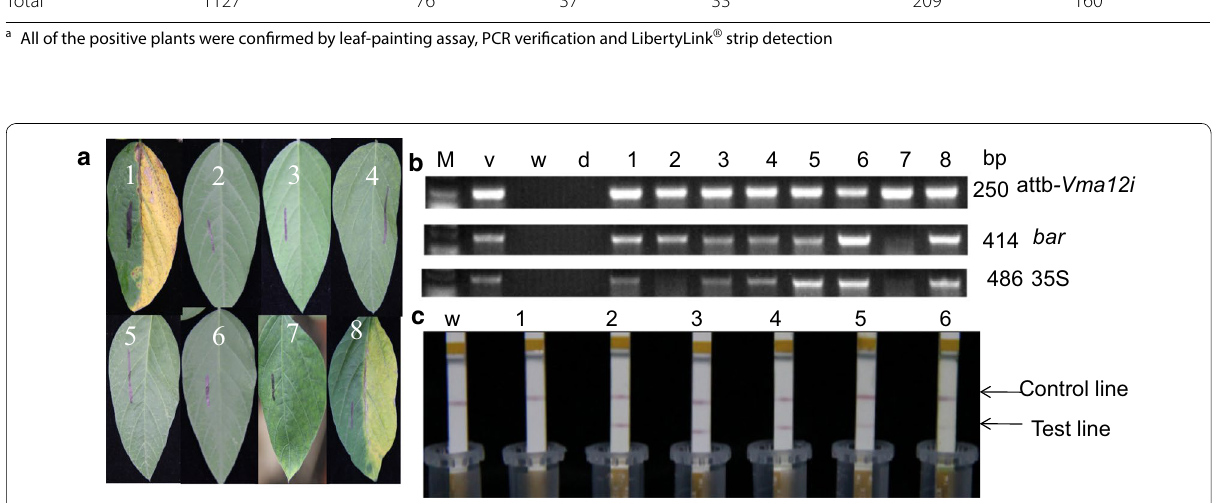
Fig. 2 Identification of T 0 transgenic soybean plants. a Identification of T 0 transgenic soybean plants by herbicide painting, 1: wild type Tianlong No.1; 2–7: herbicide resistant plants; 8: herbicide nonresistant plant. b Identification of T 0 transgenic soybean plants by PCR, M: Marker D2000; v: positive control of plasmid; w: negative control of wild-type Tianlong No.1; d: blank control of ddH 2 O; 1, 3–6 and 8: positive transgenic plants; 2 and 7: negative transgenic plant. c Identification of T 0 transgenic soybean plants by QuickStix Kit for Liberty Link (bar), w: negative control of wild-type Tianlong No.1; 1: negative transgenic plants; 2–6: positive transgenic